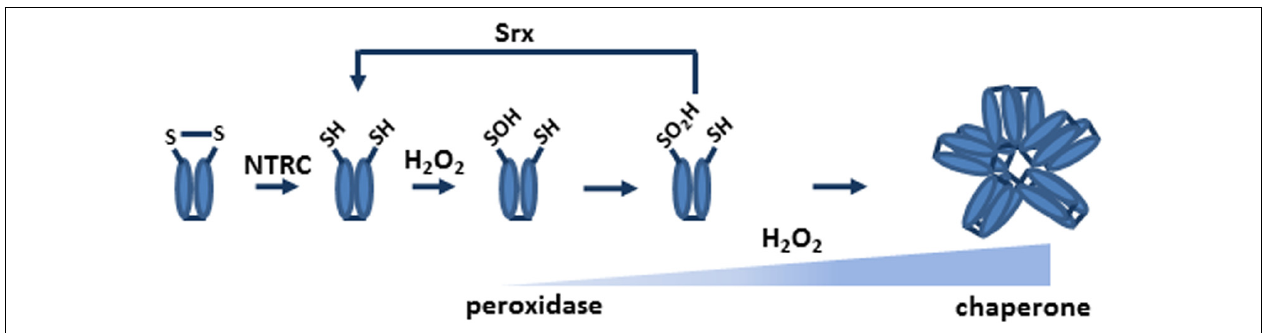
enzyme.Therefore, the redox status of chloroplast 2-Cys Prxs is highly dependent of NTRC and Srx.The quaternary structure of 2-Cys Prxs determines the activity of these enzymes. In the reduced form the enzyme is a dimer and shows peroxidase activity; overoxidation favors the formation of the decameric form, which lacks peroxidase activity and shows chaperone